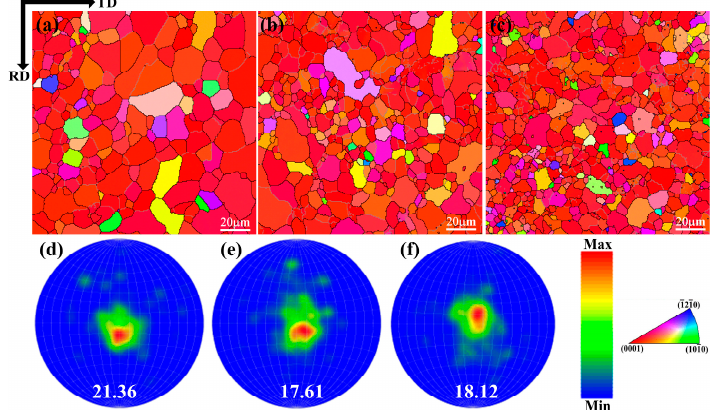
Figure 3. EBSD orientation maps and (0002) pole figures of ( a , d ) Mg–1Sn–1Zn–0.5Ca, ( b , e ) Mg–3Sn–1Zn–0.5Ca and ( c , f ) Mg–5Sn–1Zn–0.5Ca samples.